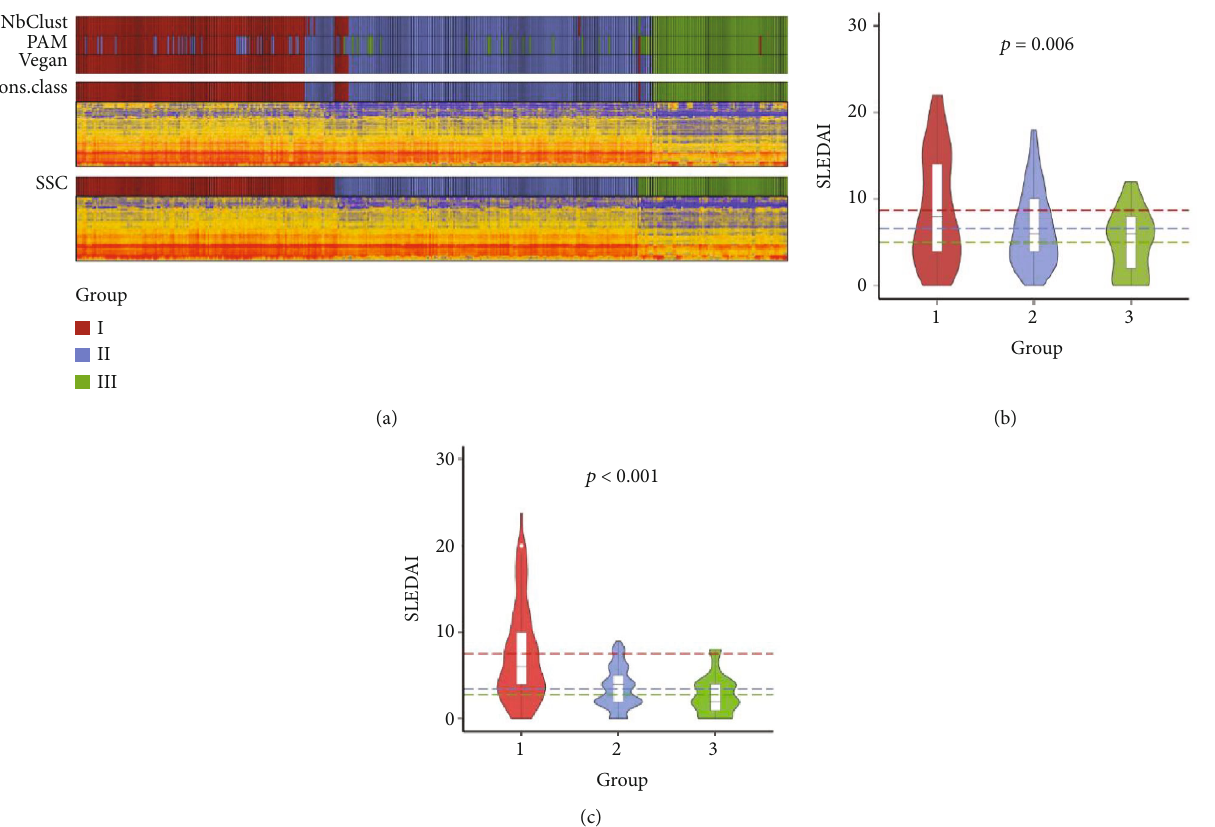
Figure 2: Molecular subtypes in SLE samples in the discovery set. (a) The model was trained to predict three classes. NbClust, PAM (partitioning around medoids), and Vegan reveal that the optimal number of subtypes is three. Calling these three algorithms to classify patient samples, the results showed strong consistency. After further correction based on the consensus category, we got a more accurate result. (b) SLEDAI in the subtypes after correction. There are di ff erences in the mean values of the three subtypes of SLEDAI, and the di ff erences of overall and between subtypes are signi fi cant, re fl ecting the accurate allocation of samples after correction. (c) SLEDAI in the subtypes in the validation